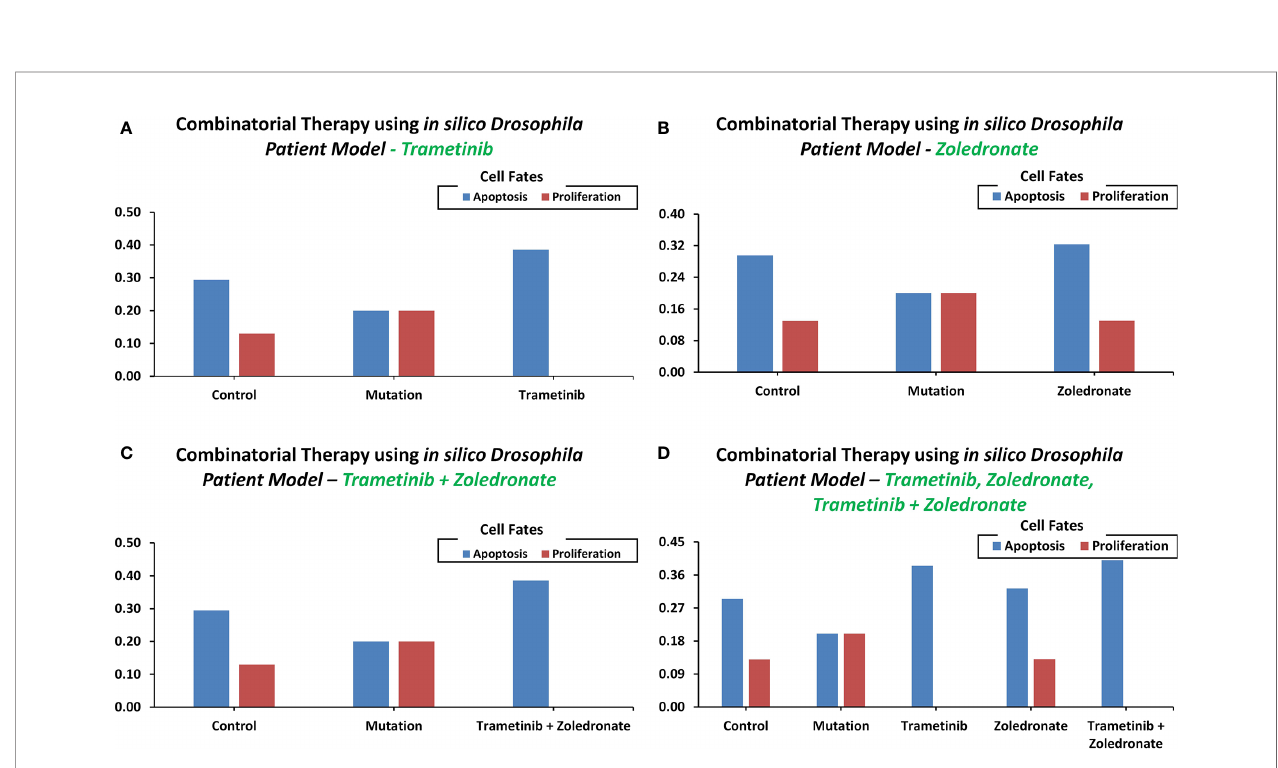
FIGURE 6 | Cell fate propensities were obtained from the in vivo Drosophila Patient Model using Bangi et al.'s study. Cell fate propensities under (A) control, mutated, and therapy (Trametinib), (B) control, mutated, and therapy (Zoledronate), (C) control, mutated, and therapy (Trametinib + Zoledronate), (D) control, mutated, and therapy (Trametinib, Zoledronate, and Trametinib +